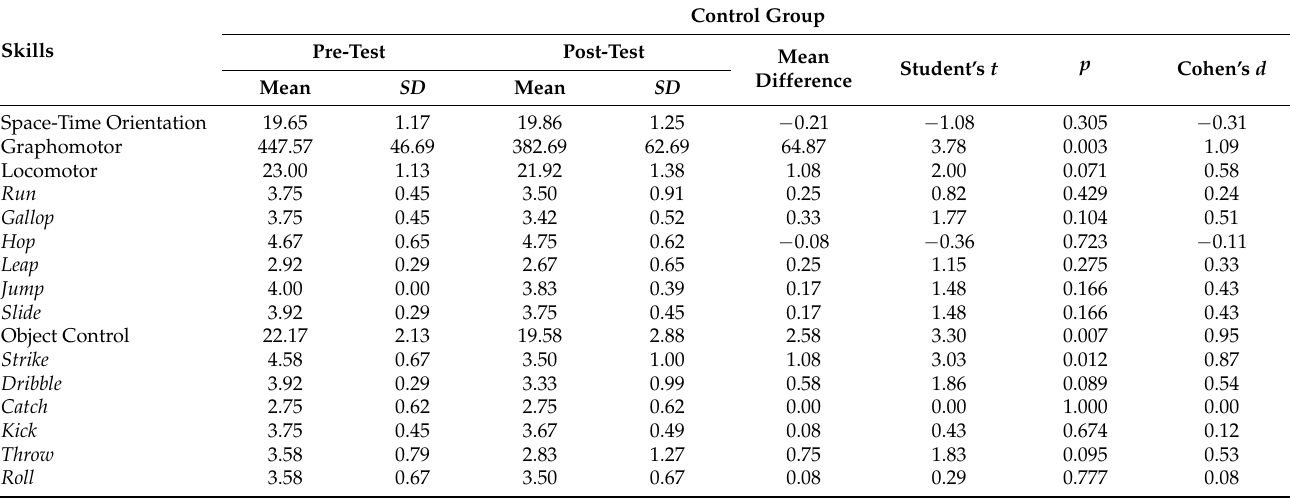
Table 1. Mean and standard deviation of the control and experimental group in the pre-test and post-tests, and the paired samples t -test